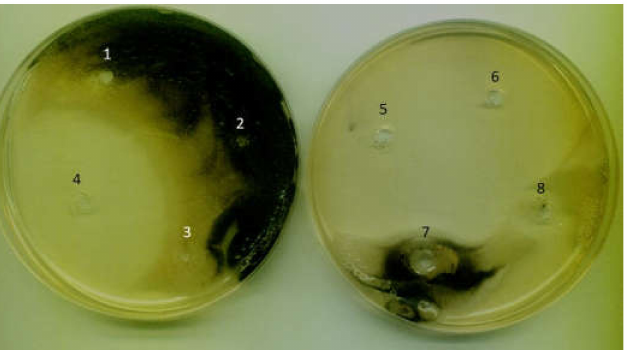
Figure 6. In vitro evaluation antimicrobial activity of selected chemicals on A. pullulans strain. ( 1 ) LPSQ; ( 2 ) Me 3 SiVi; ( 3 ) VMS-T11; ( 4 ) thioglycolic acid; ( 5 ) cysteamine; ( 6 ) n -propylamine; ( 7 ) Me 3 SiCH 2 CH 2 SCH 2 COOH; ( 8 )